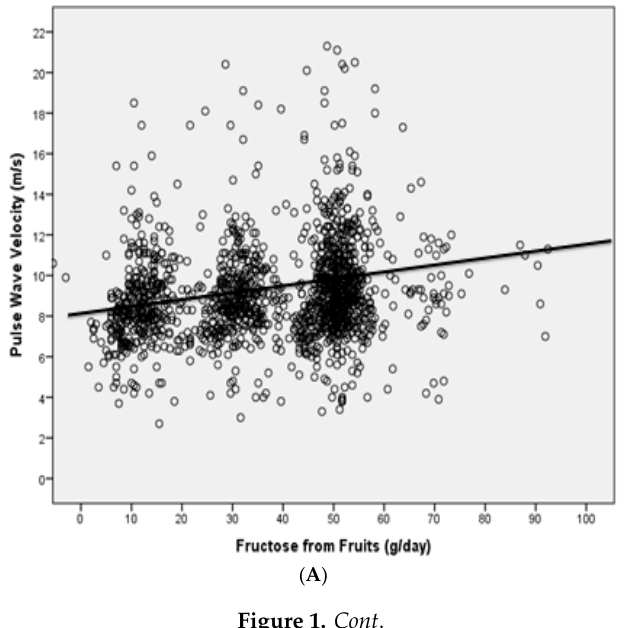
Table 1. Categorical variable distribution in the studied population